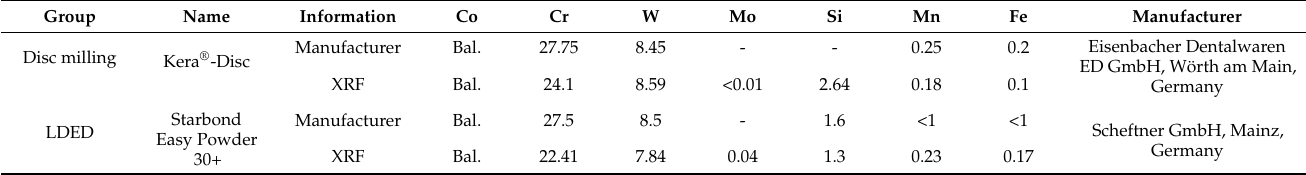
Table 1. Chemical composition (wt. %) of the Co-Cr-W alloys used in this work.